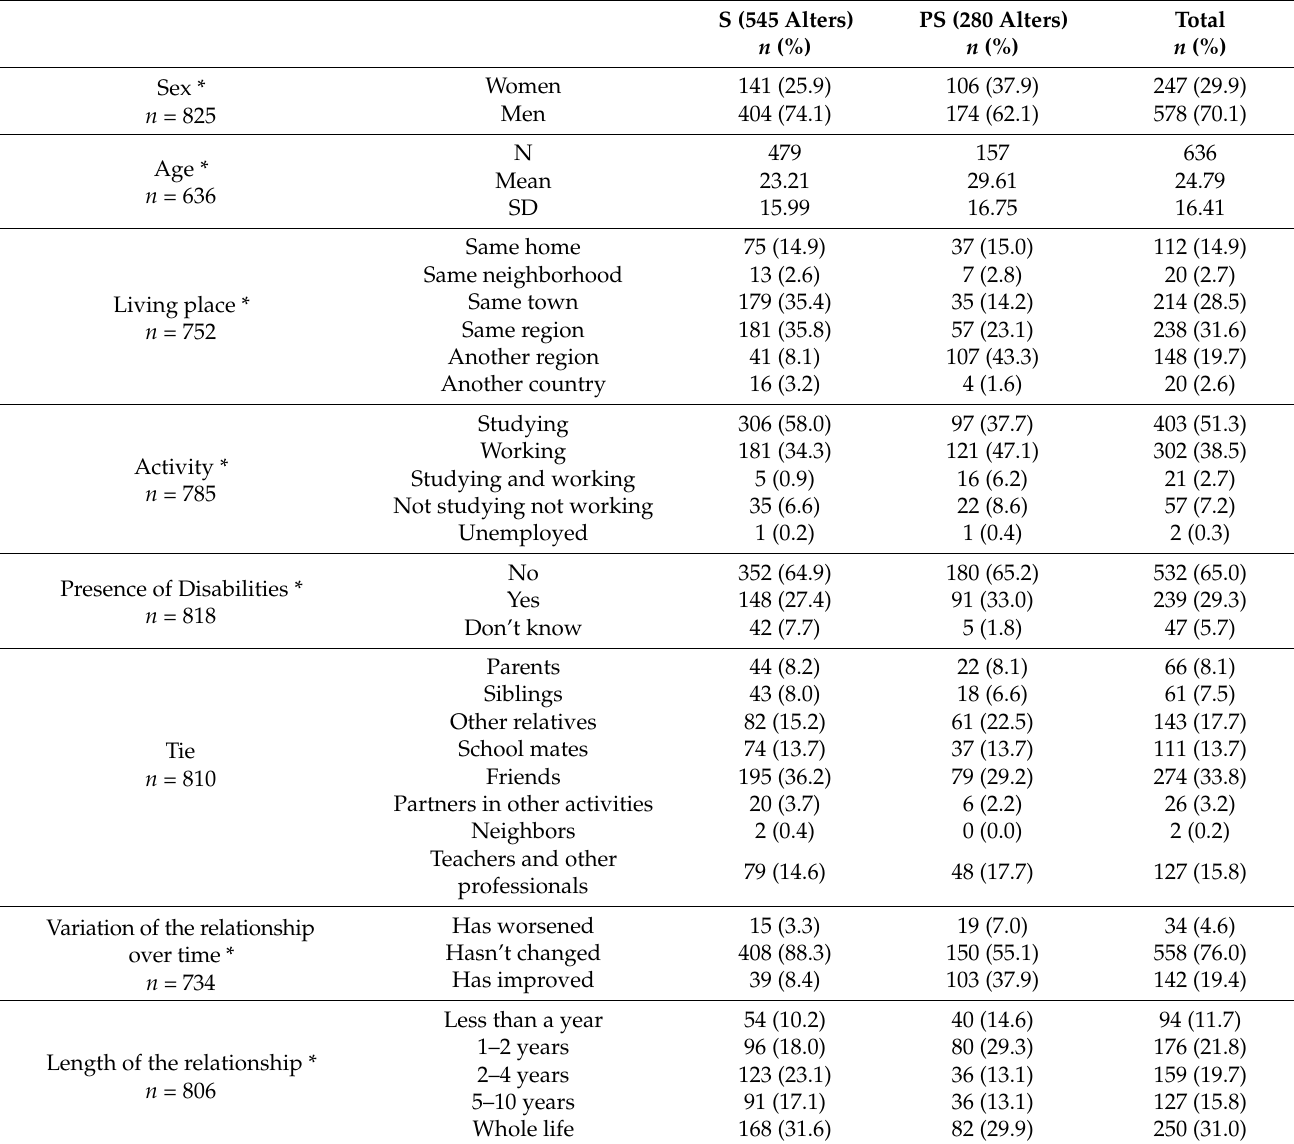
Table 2. Compositional characteristics of personal networks of the S and PS